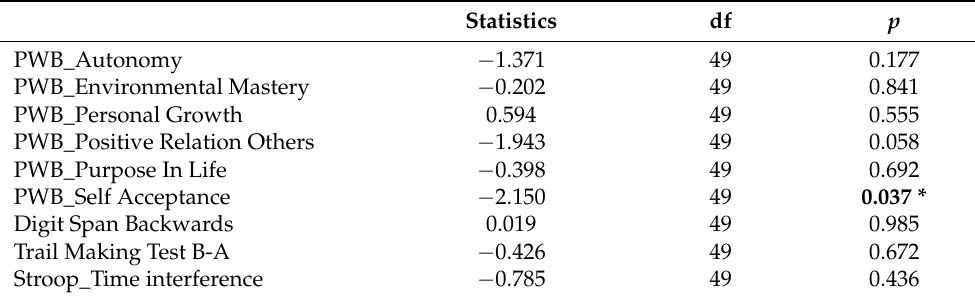
Table 2. Independent sample t-tests to control for gender differences in perceived PWB and execu- tive